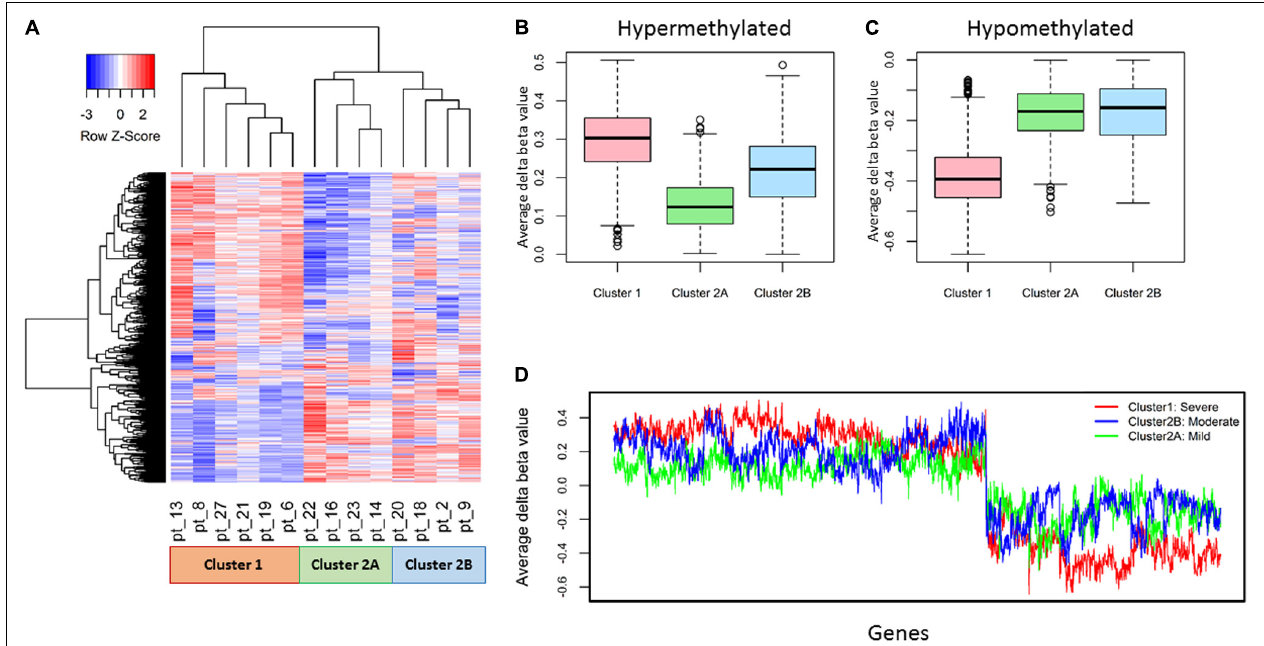
FIGURE 2 | Representation of differential DNA methylation profile ( (cid:49) β ) of 2,316 promoter genes in 14 patients. (A) Unsupervised hierarchical clustering and heatmap classified 14 OPSCC patients into two major clusters, further cluster 2 consisted of two sub clusters. (B,C) The ranges of average (cid:49) β values clearly elucidates that DNA methylation alternations found in Cluster 1: severe, Cluster 2A: mild, Cluster 2B: moderate respectively from box and whisker plot. (D) The cluster wise distribution of average (cid:49) β values of each gene depicts extreme level of hyper and hypo methylation in cluster 1 whereas cluster 2A shows minimal DNA methylation